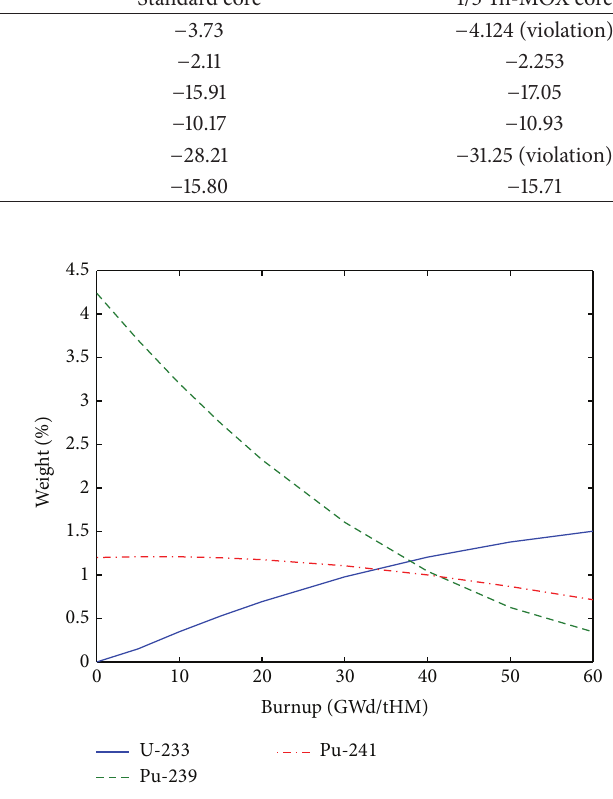
Figure 12: The amount of the fissile isotopes U-233, Pu-239, and Pu- 241 in the Th-MOX fuel